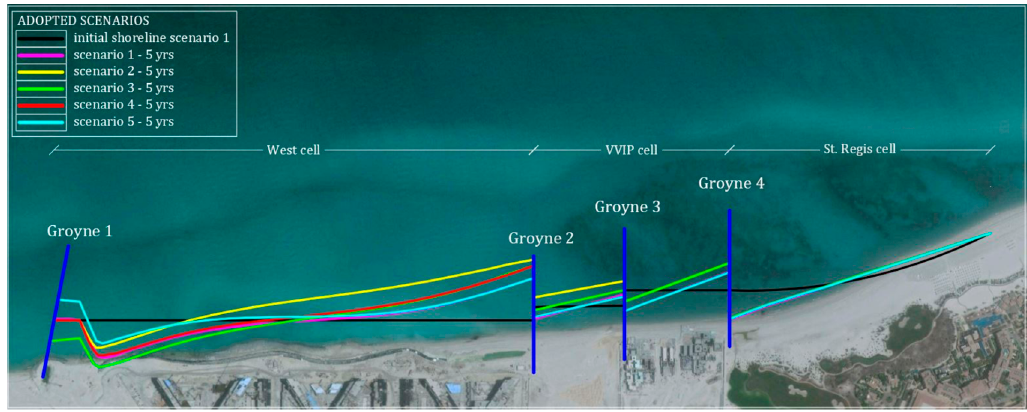
Figure 10. Evolution of the initial shoreline after 5 years, for the different considered scenarios.